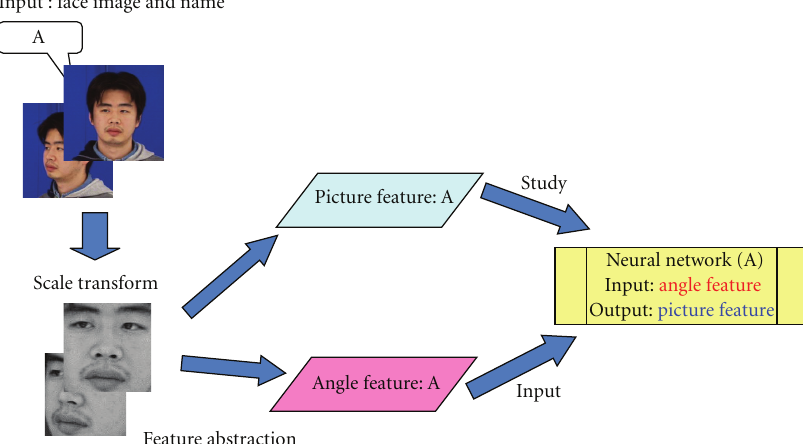
Figure 8: Registration phase which consists of taking the face image at di ff erent angles and use them to train an MLP.